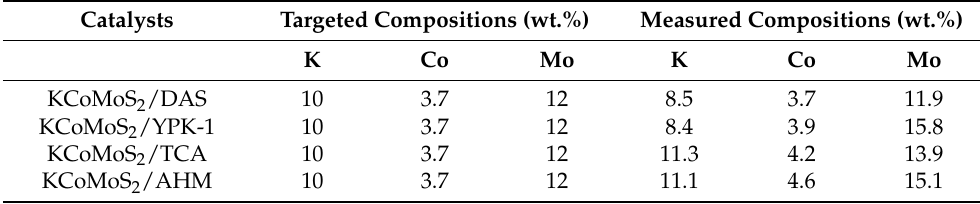
Table 2. Composition of prepared catalysts based on X-ray fluorescence spectroscopy data.